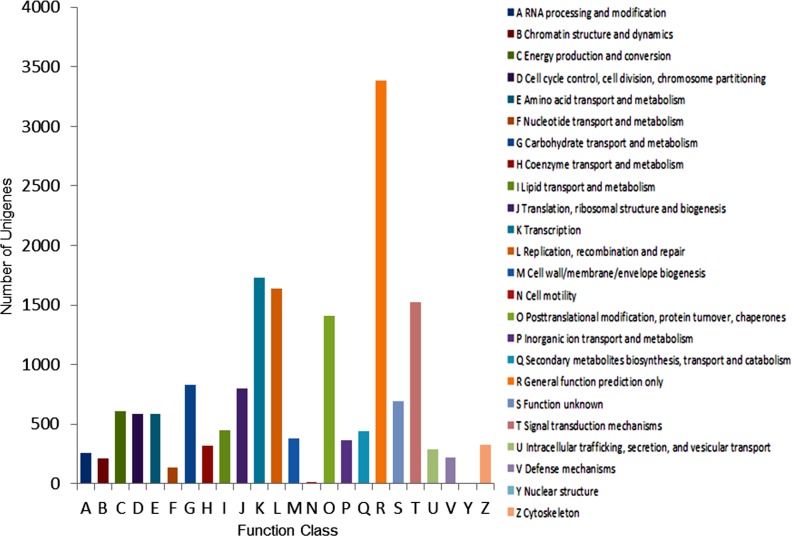
COG function classification of ‘Hangbaishao’ unigenes.